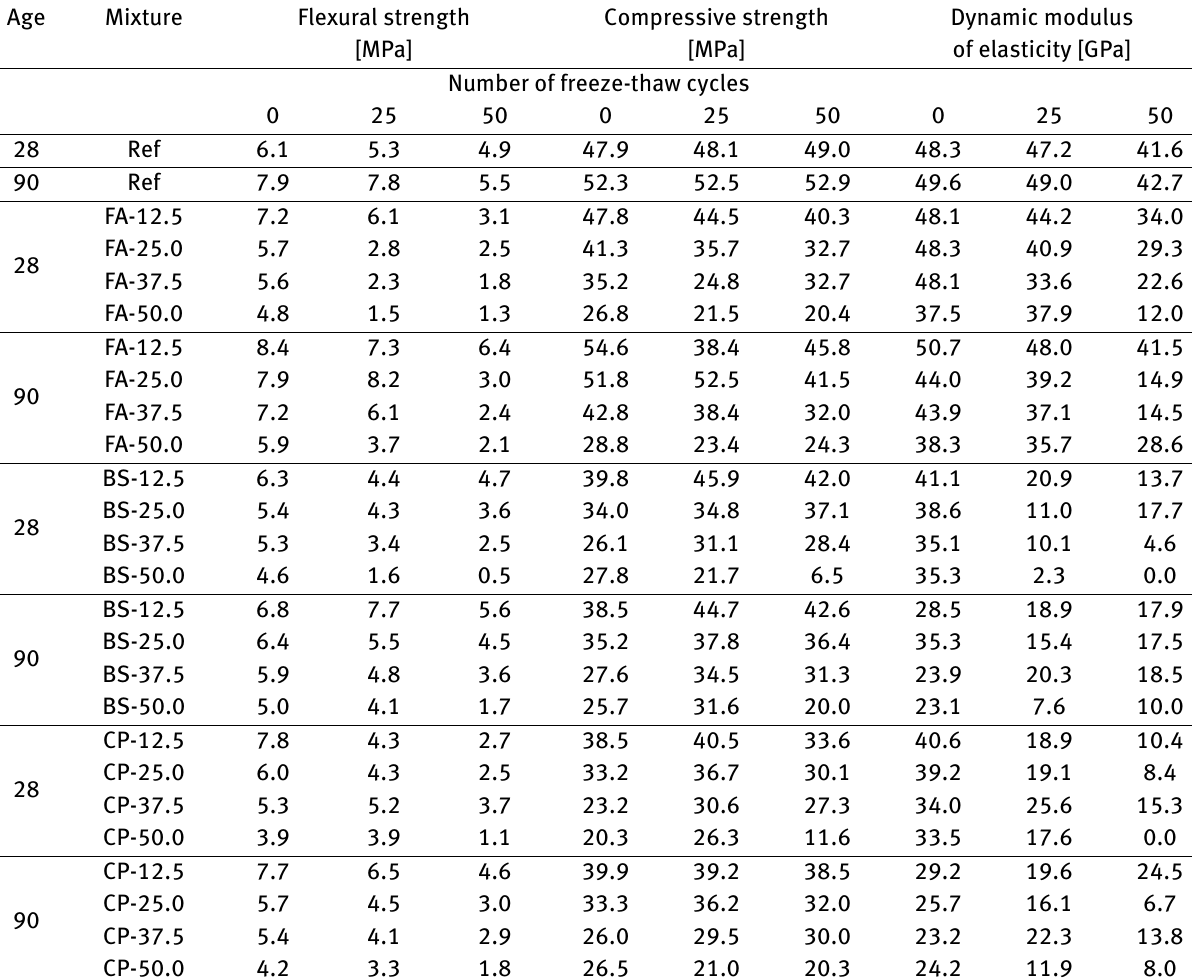
Table 3: Detailed results of mechanical properties of studied mixtures during freeze-thaw cycling.